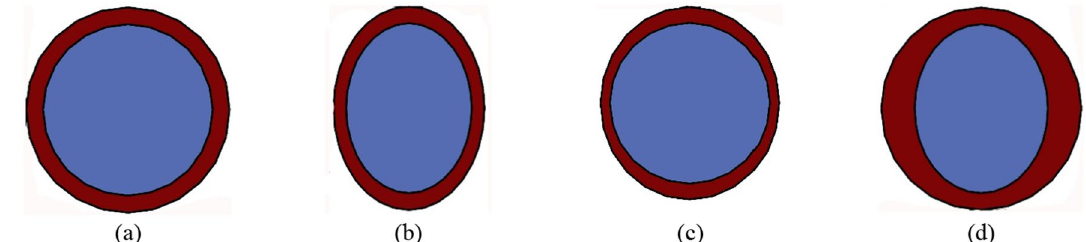
Figure 4. Schematic representation of possible cross-sectional variations of GAA structure due to fabrication imperfections: ( a ) circular oxide—circular channel (COCC), ( b ) elliptical oxide—elliptical channel (EOEC), ( c ) elliptical oxide—circular channel (EOCC), ( d ) circular oxide—elliptical channel